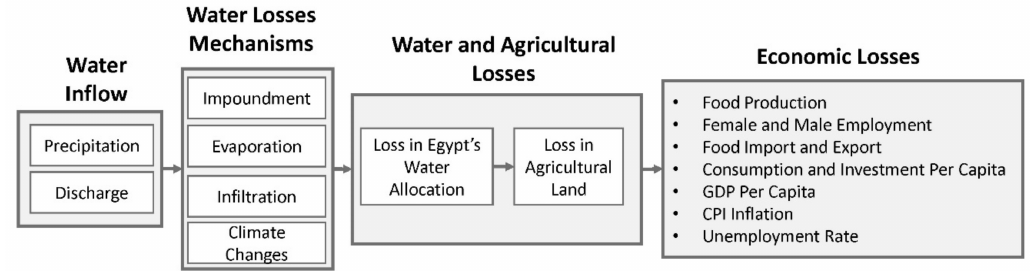
Figure 2. Egypt’s water and economic losses due to GERD